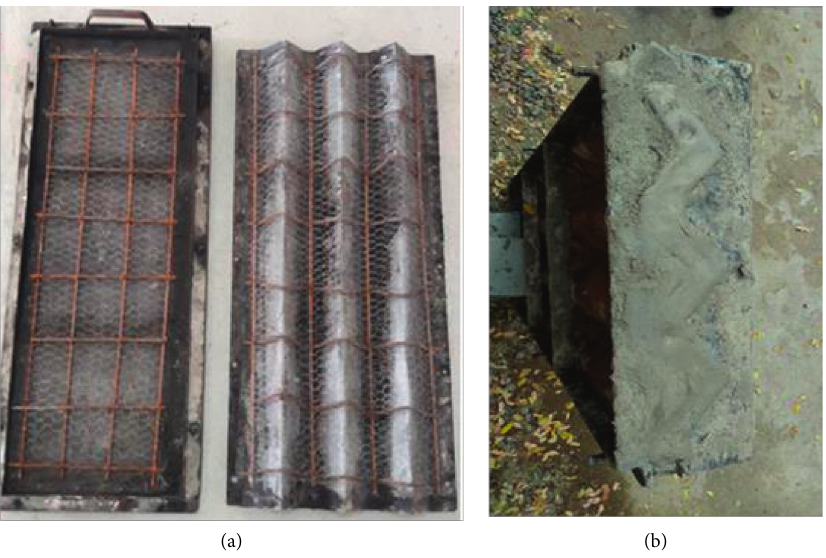
Figure 4: Fabrication and casting specimens. (a) Fabrication of reinforcement. (b) Casting specimens.